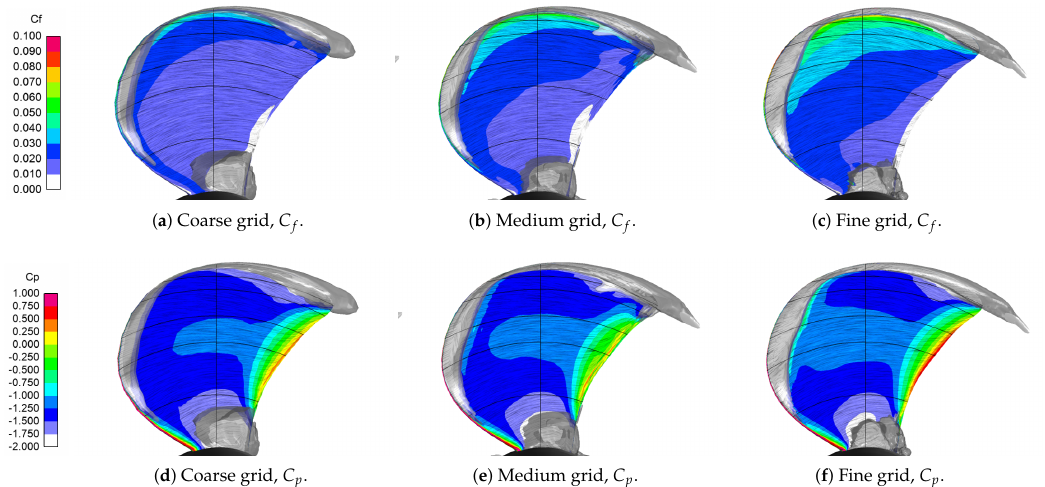
Figure 18. Comparison of near-blade cavitation results with different grid densities. Top row: skin-friction coefficient. Bottom row: pressure coefficient. Full-scale simulations for PPTC Case